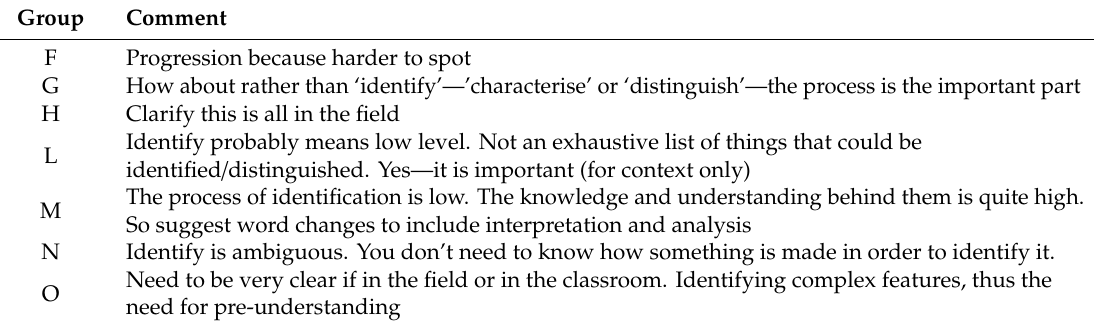
Table A1. Identify landform features